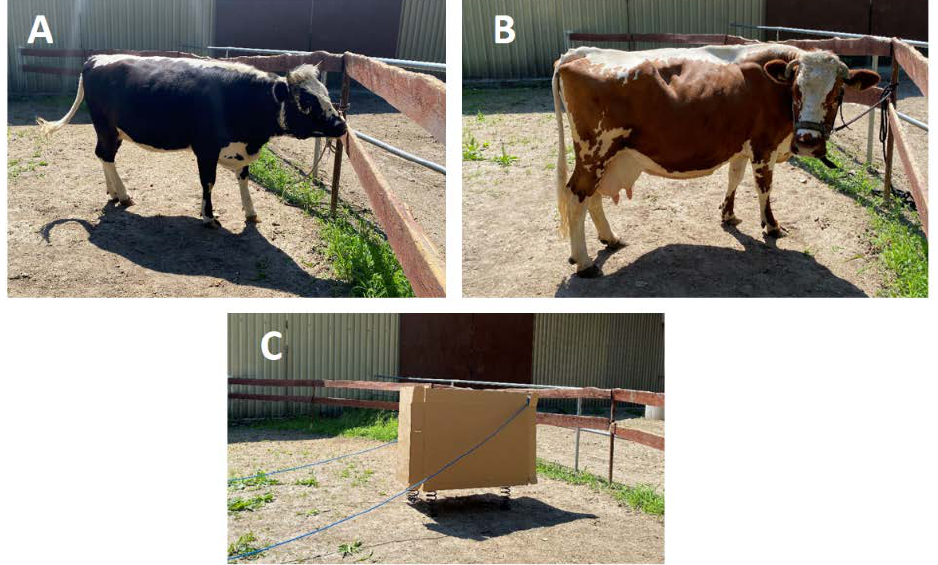
Figure 1. The stimuli used in the study: Cow1 ( A ), Cow2 ( B ) and the Box ( C ). The cows were tethered for the photo but free to move during the study. Two electric cables power the mechanism hidden in the cardboard box.